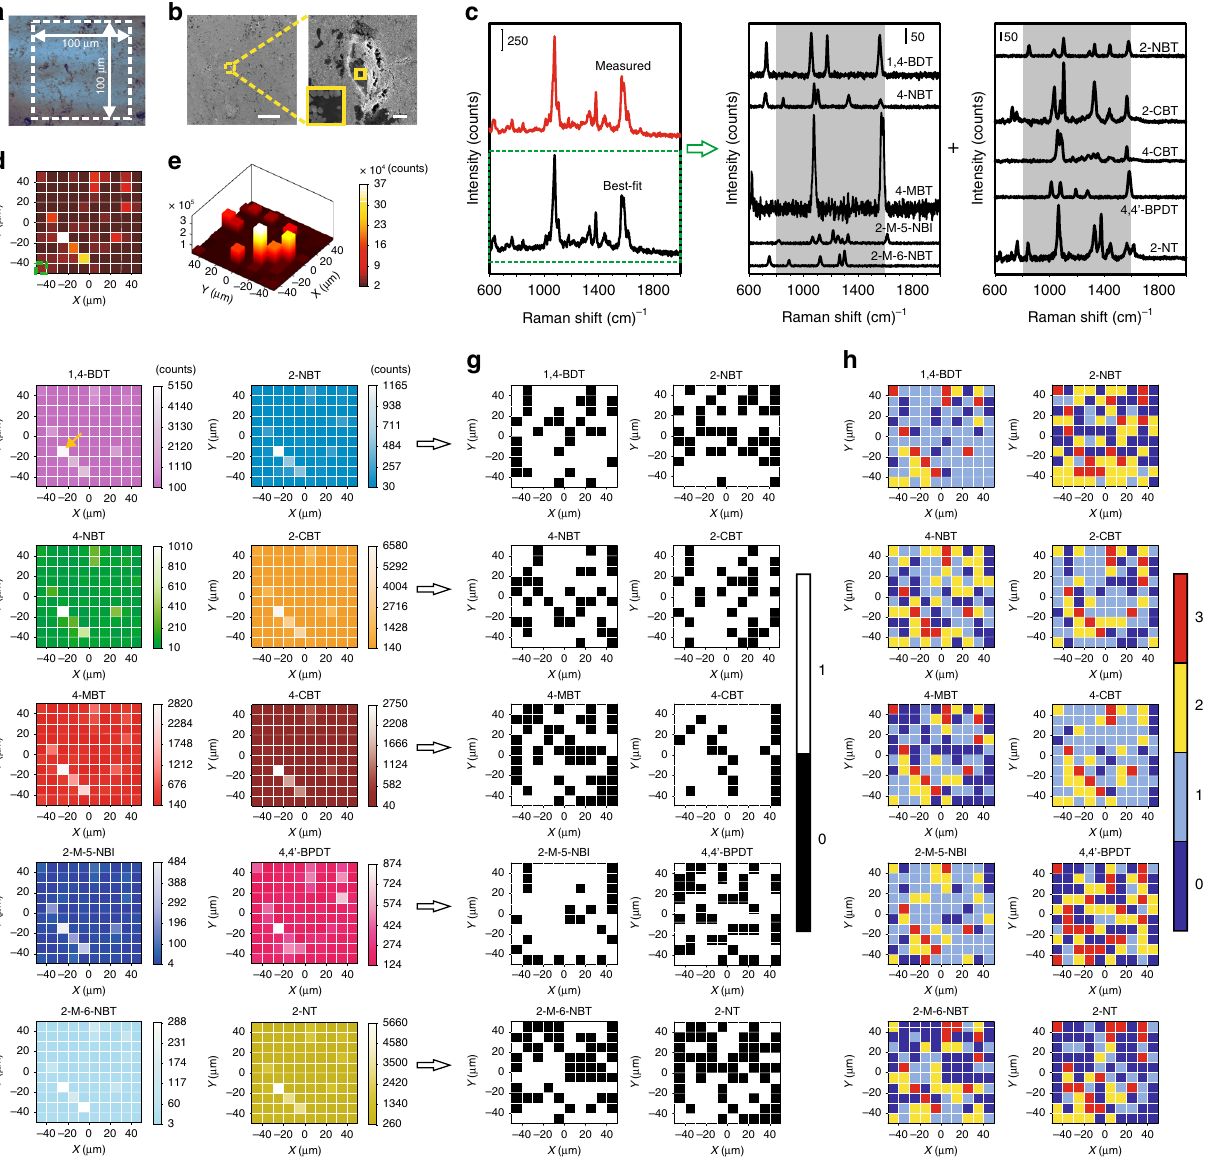
Fig. 4 Fabrication and digitization of a PUF label composed of ten types of GERTs. a A bright- fi eld image and b the scanning electron microscopy image (corresponds to the dashed square area in a of a PUF label fabricated by ten types of GERTs in an area of 100 × 100 μ m 2 on a SiO 2 substrate. Scale bars are 20 (left) and 1 μ m (right). c Spectral demultiplexing to quantify the abundance of ten types of GERTS at the position indicated by a green dashed box in panel d . The best- fi t spectrum (black) is obtained by fi tting the measured Raman spectrum (red) with ten pure reference Raman spectra using the non- negative least squares (NNLS) method. d 2D and e 3D plot for the readout of the PUF label by the Raman mapping (with a resolution of 10 × 10 pixels) of multiplexed measured Raman signals using the integrated areas of Raman bands from 802 to 1600 cm − 1 (as indicated in the gray area in panel c ). f 2D plot for the readout of the PUF label by the Raman mapping (with a resolution of 10 × 10 pixels) of demultiplexed Raman signals and 2D plot of the corresponding digitizations using g binary encoding and h quaternary encoding of Raman intensity levels at each